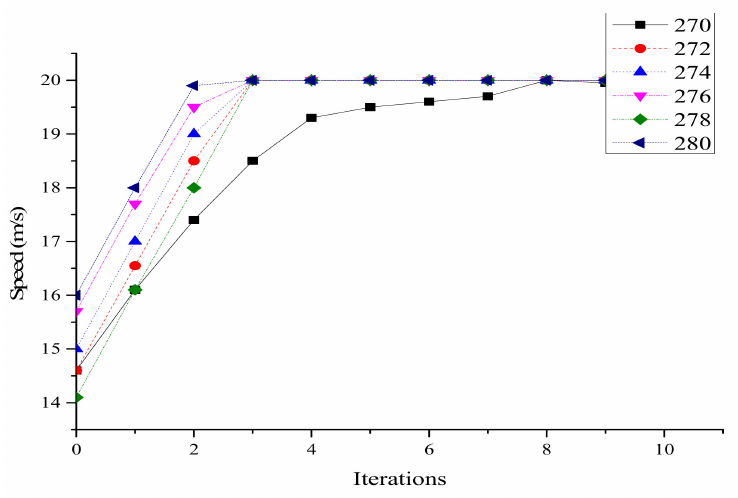
Figure 4. Optimized vehicle speed on lane 1.